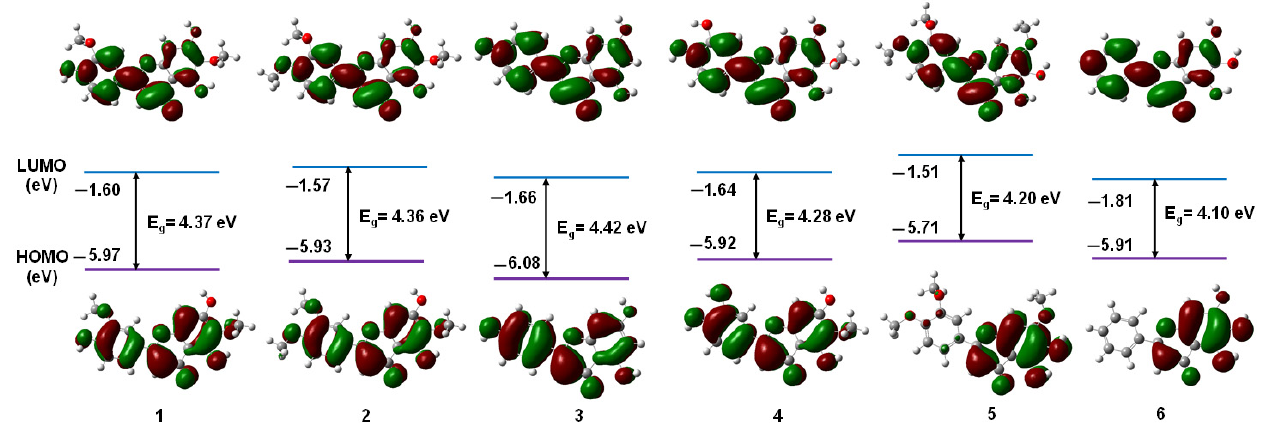
Figure 2. The energy gap and distribution of HOMO and LUMO of compounds 1 – 6 .